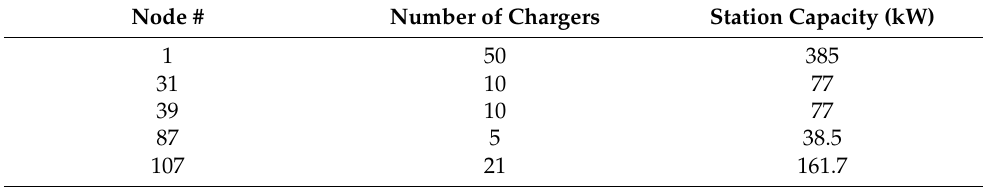
Table 3. Locations and rated capacities of